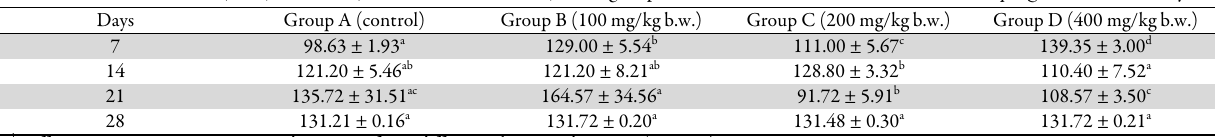
Table 2. Mean serum ALP (IU/l) activities (means ± standard error) of rat groups administered methanol fruit extract of Piper guineense for 28 days Days Group A (control) Group B (100 mg/kg b.w.) Group C (200 mg/kg b.w.) Group D (400 mg/kg b.w.)